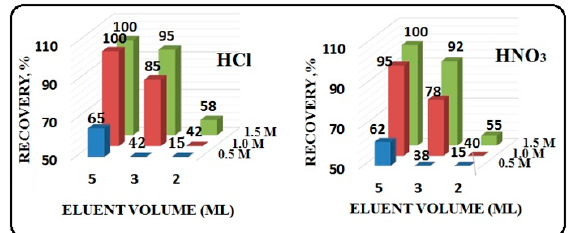
Figure 7. Optimization of eluent type, volume and concentration.